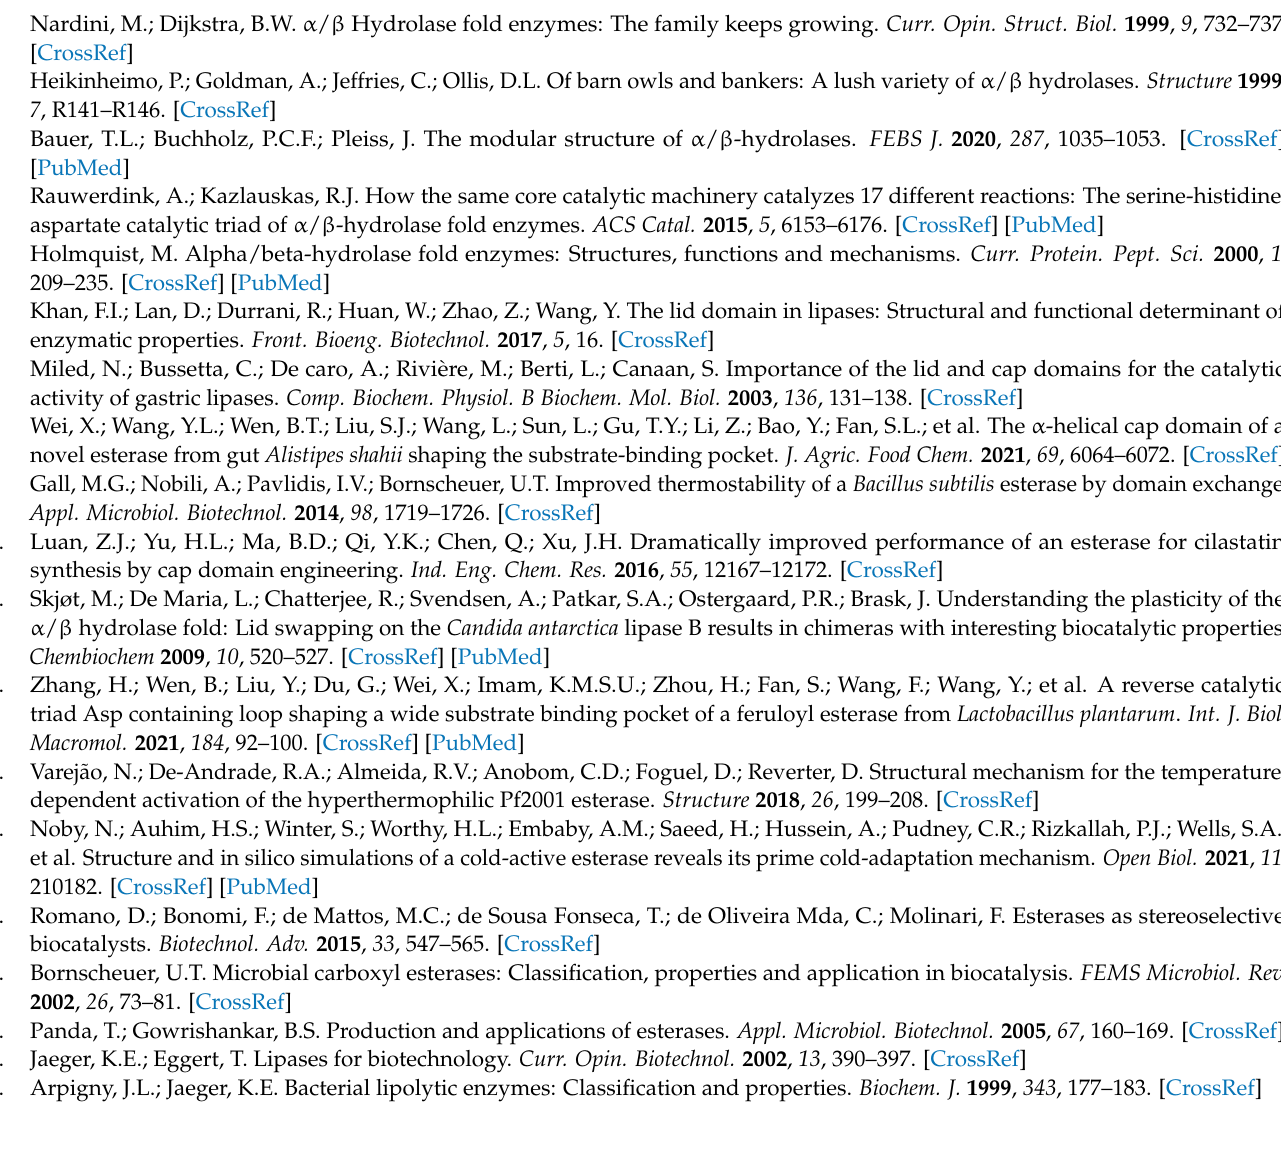
Figure S4. Michaelis-Menten kinetic plots for arylesterase LggEst deleted mutant on the hydrolysis of the p -nitrophenyl